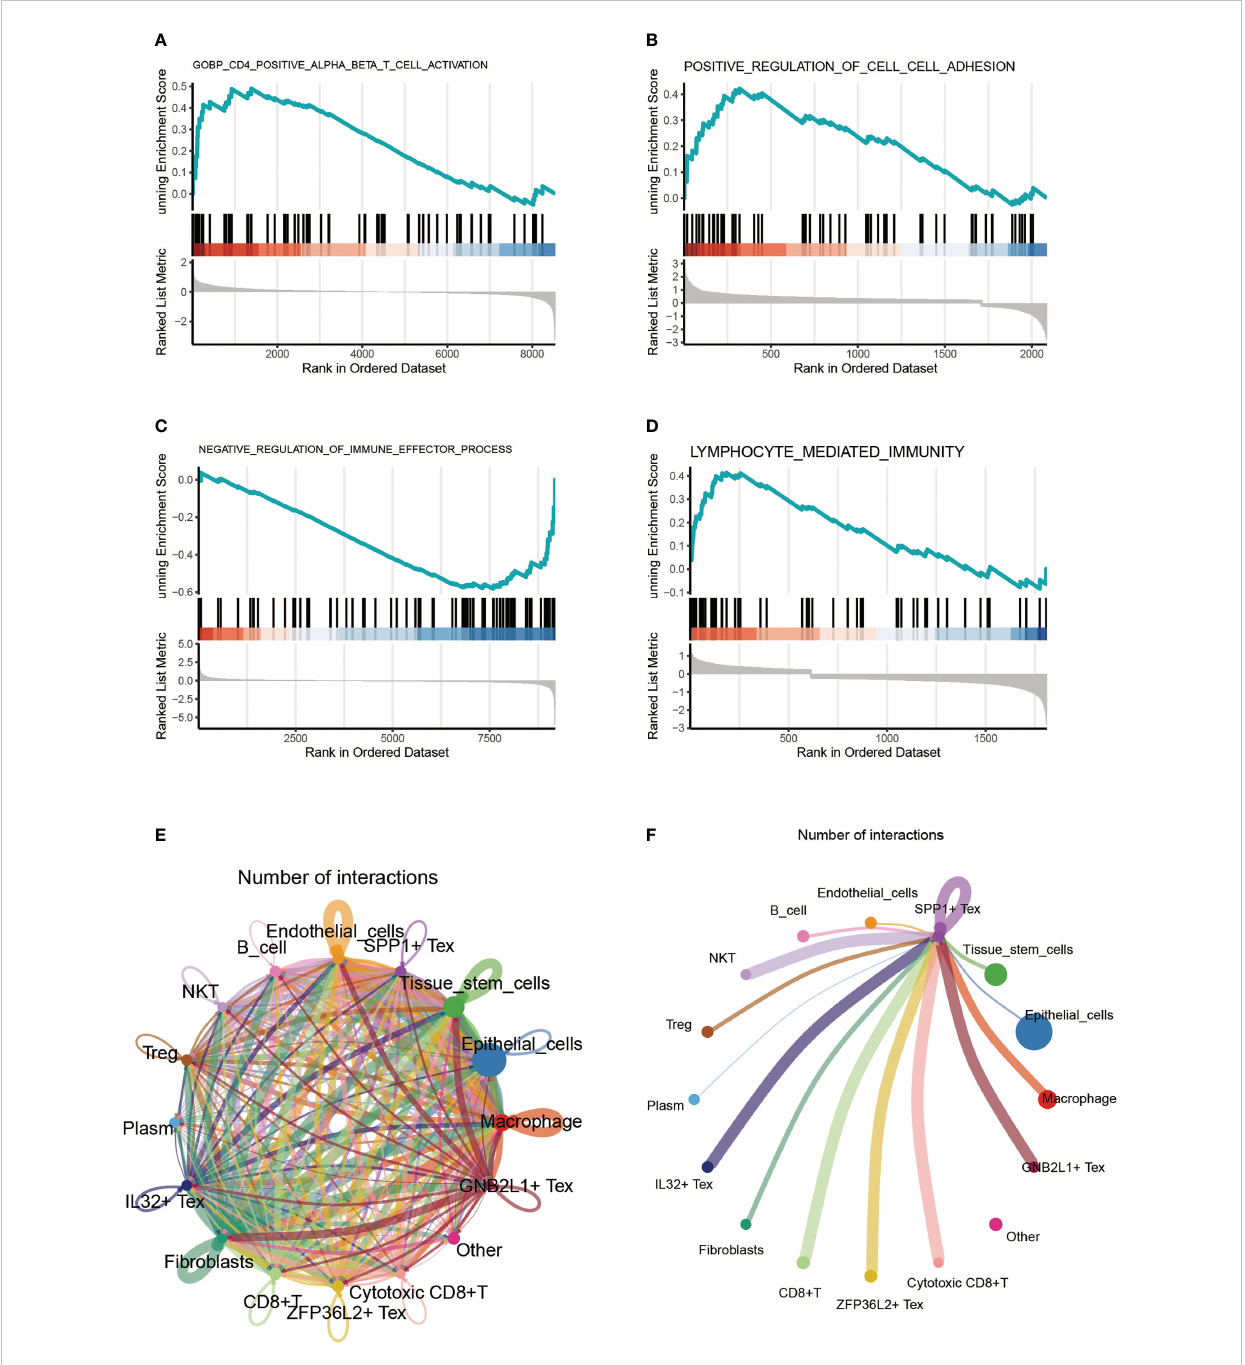
FIGURE 4 Cell-enriched pathway analysis. (A-D) GSEA analysis comparing enriched pathways in four Tex cells. (E) Shown the pathway analysis between cells. (F) Signaling pathway of SPP1 + Tex to other